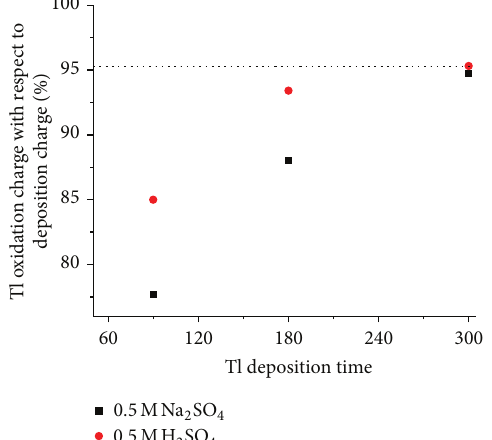
Figure 12: Plot shows the percentage of charge corresponding to thallium oxidation with respect to the deposition charge against its deposition time.